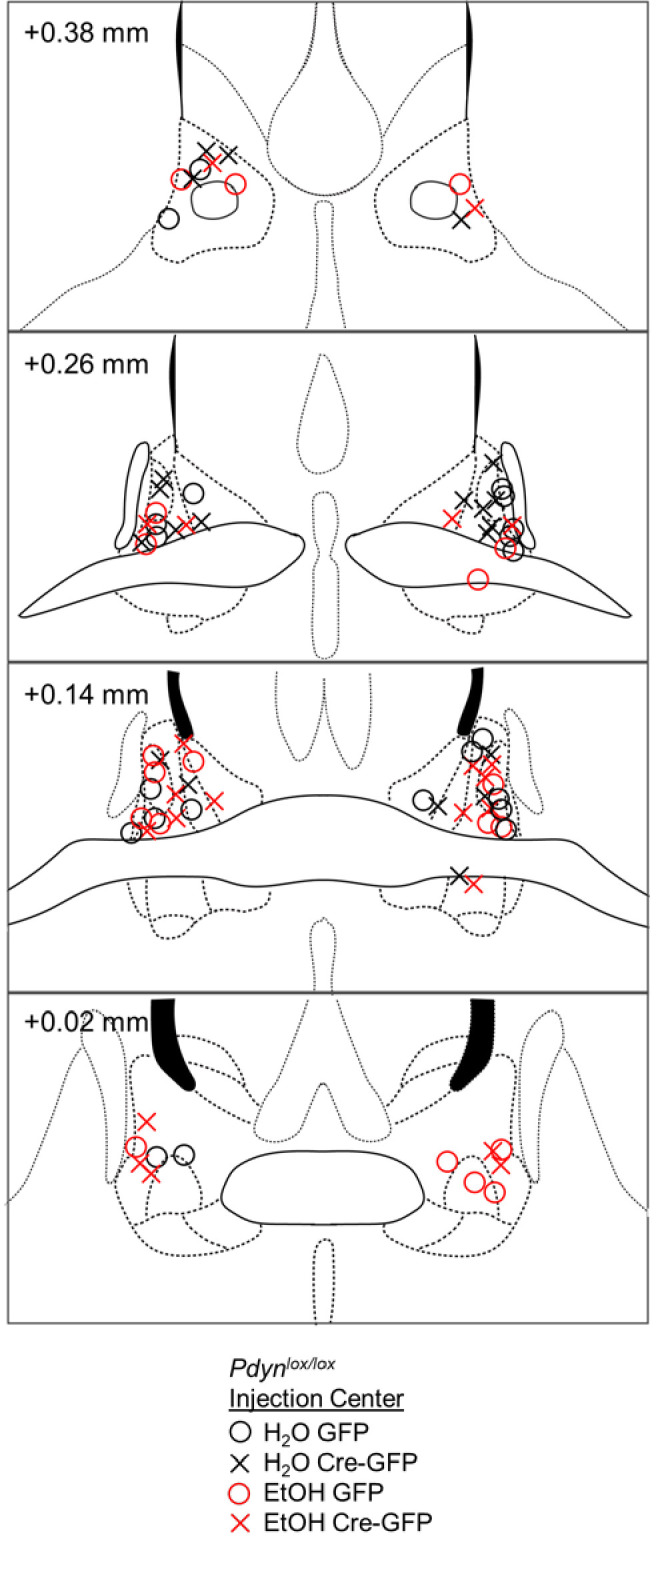
Histological verification of BNST Pdyn deletion.Correct BNST placements of AAV-Cre-GFP or AAV-GFP infusion are shown in coronal sections in millimeters from bregma in a floxed Pdyn mouse line. Injection centers are represented by circles for GFP or crosses for Cre-GFP.